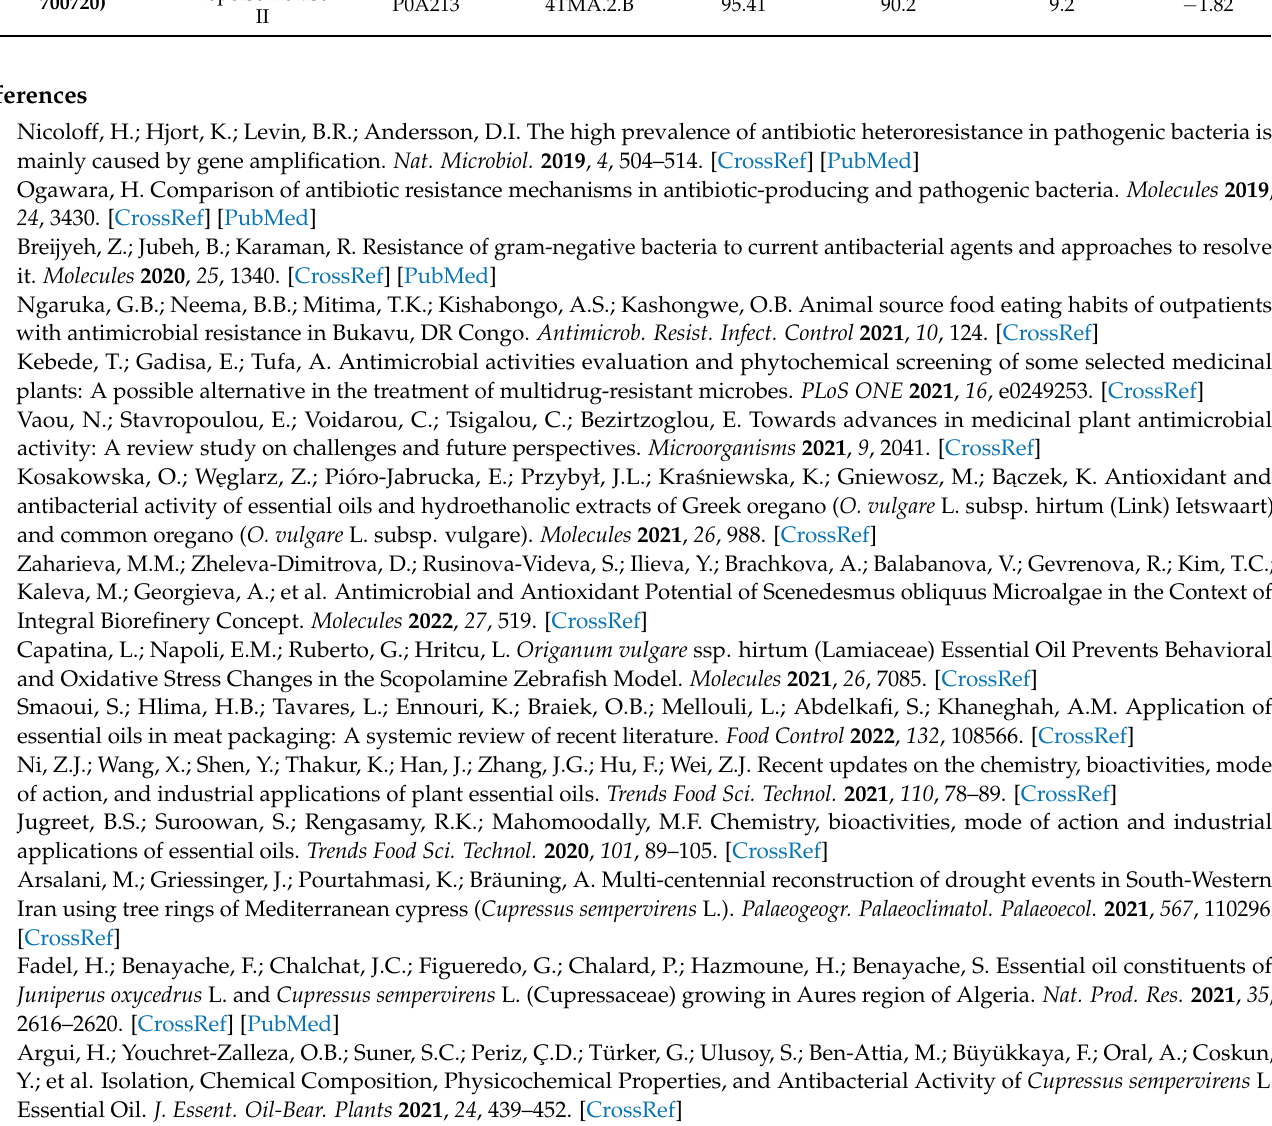
Sample Availability: Samples of the compounds are not available from the authors.